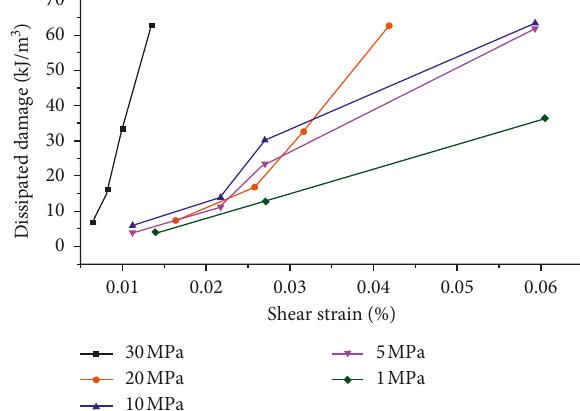
Figure 6: Relationship between shear strain and dissipated energy under different confining pressures.